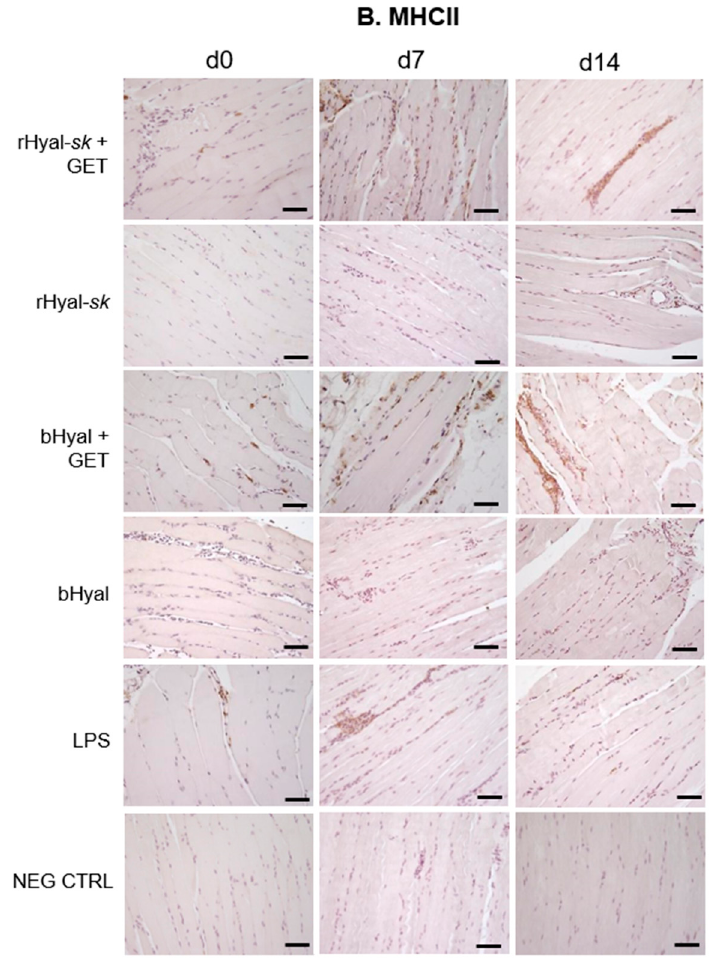
Figure 3. Figure 3 . Cont.